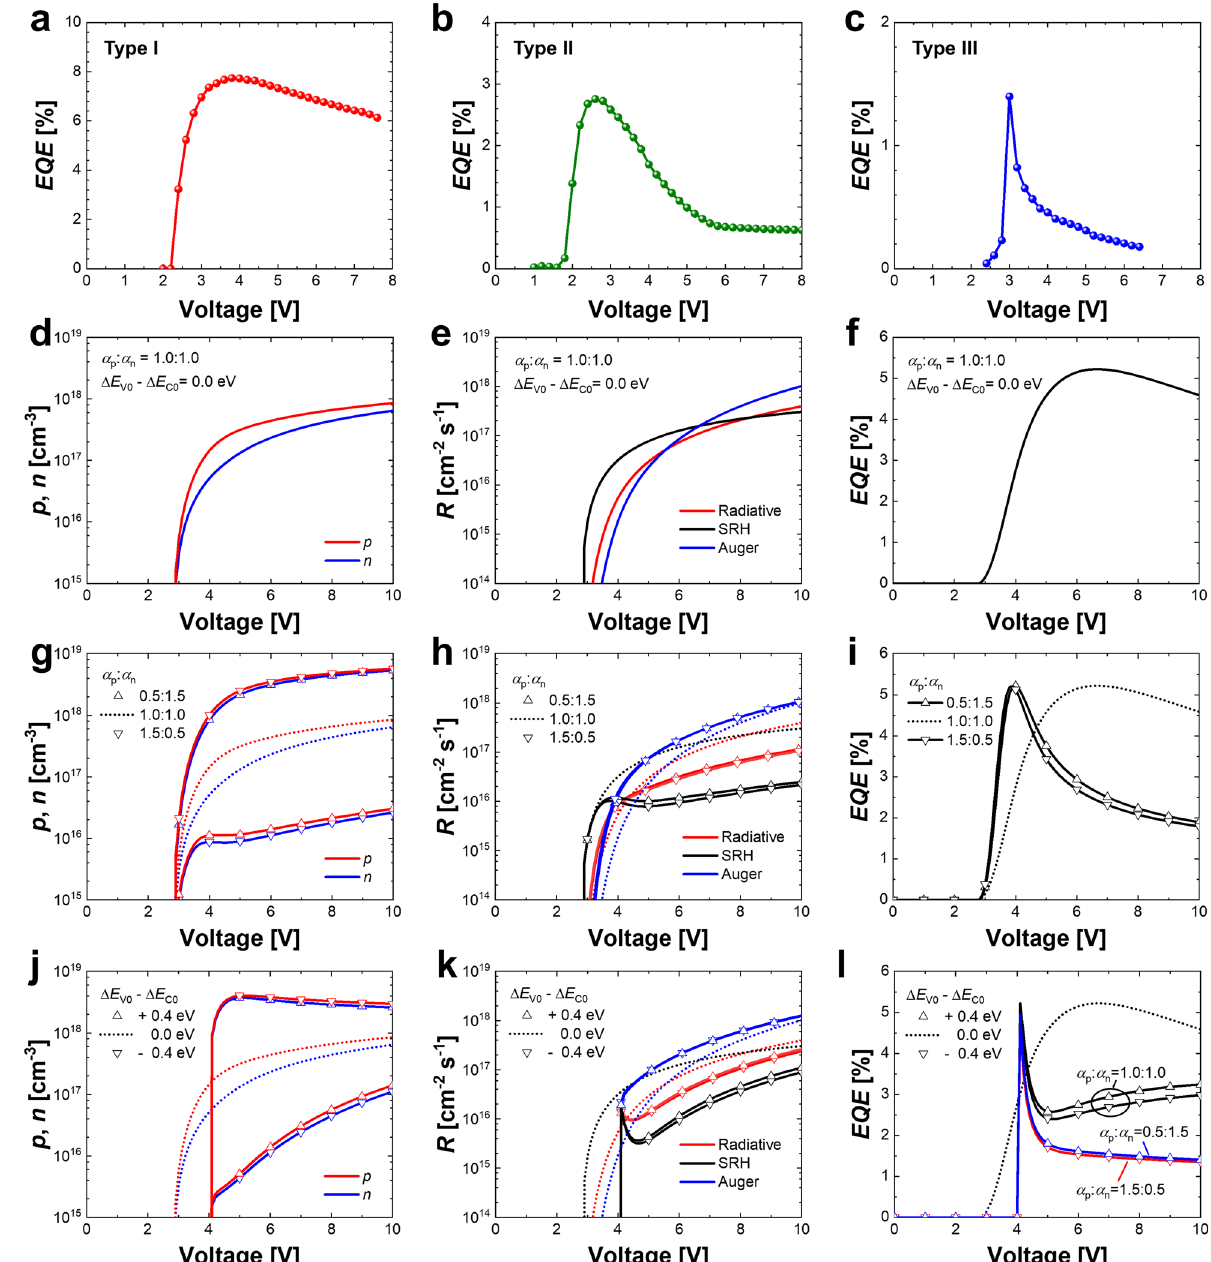
Fig. 4 Changes of the EQE curve according to the various charge balance conditions. a – c Typical EQE curves obtained by experiments for the various device and process conditions. Voltage dependences of d hole and electron densities, e radiative, SRH and Auger recombination rates and f EQE curves for the charge-balanced condition that α p = α n with Δ E V0 = Δ E C0 . Voltage dependences of g hole and electron densities, h radiative, SRH and Auger recombination rates and i EQE curves for the condition that α p ≠ α n ( α p : α n = 0.5:1.5 for electron-rich and 1.5:0.5 for hole-rich conditions) with Δ E V0 = Δ E C0 . Voltage dependences of j hole and electron densities, k radiative, SRH and Auger recombination rates and l EQE curves for the condition that Δ E V0 ≠ Δ E C0 ( Δ E V0 − Δ E C0 = + 0.4 eV for electron-rich and Δ E V0 − Δ E C0 = − 0.4 eV for hole-rich measured to be 31,230 cd m − 2 at 6.0 V, 79,520 cd m − 2 at 7.6 V and a set of red, green and blue QD-LED devices. The electro-optical characteristics of the QD-LEDs obtained from the experiments are 1423 cd m − 2 at 8.0 V, respectively, while their threshold voltages plotted in Fig. 5a, b. The inset in Fig. 5a shows the snapshots of the are observed to be 1.8, 2.2 and 4.0 V, respectively. The maximum fabricated red, green and blue QD-LEDs. The CdSe/ZnS core/shell EQEs are found to be 10.5% at 4.0 V, 7.7% at 3.8 V and 1.6% at red and green QDs with their diameters of 7 nm and 5 nm, 5.4 V, respectively, and their EQEs slightly drop to 10.0% at 6.0 V, respectively, are used for red and green QD-LED devices 46 , and 6.5% at 7.6 V and 1.2% at 8.0 V for the respective devices (Fig. 5b). Figure 5c, d shows the luminance, current density and EQE cadmium zinc sulphide (CdZnS)/ZnS QDs with its diameter of curves emulated by our charge transport simulation model with 10.8 nm is used for the blue QD-LED devices. From Fig. 5a, the adjusted material and device parameters. The simulation luminance values of red, green and blue QD-LED devices are